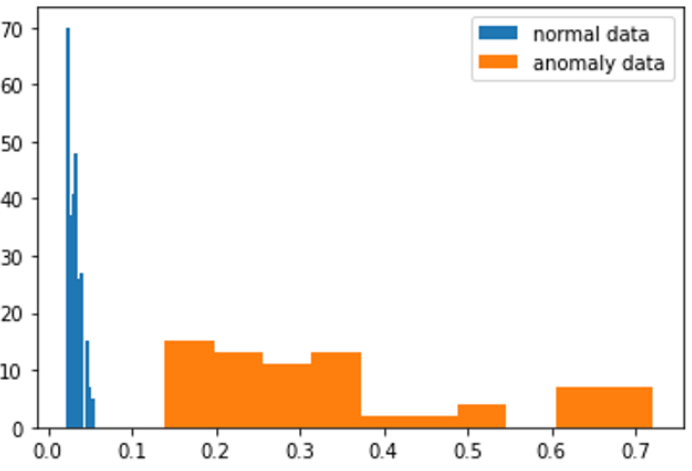
Figure 8. Histogram of anomaly score.